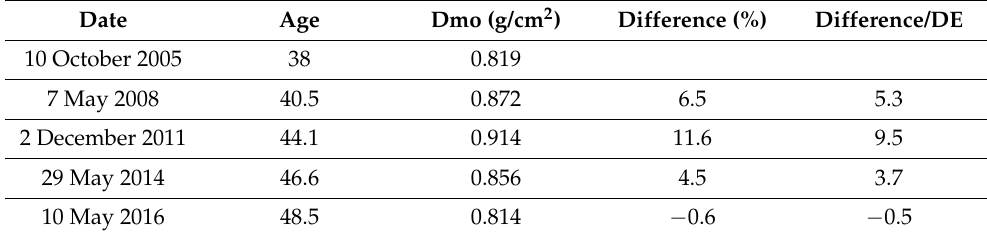
Table 1. Evolution of the reviewed parameters of bone densitometries of the spine.